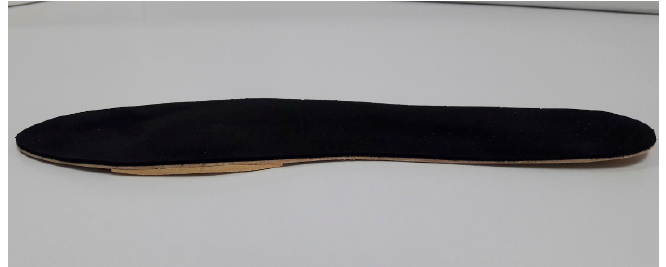
Figure 1. Novel inverted rocker orthotic (NIRO).